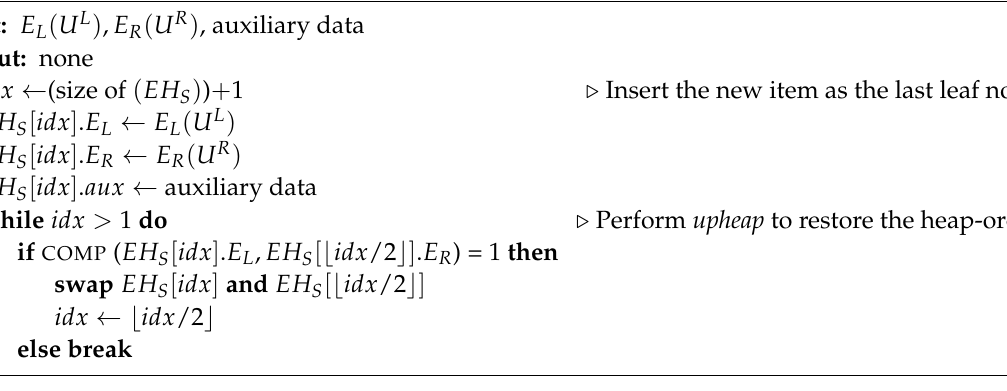
Algorithm 1 INSERT procedure for encrypted min-heap EH S .